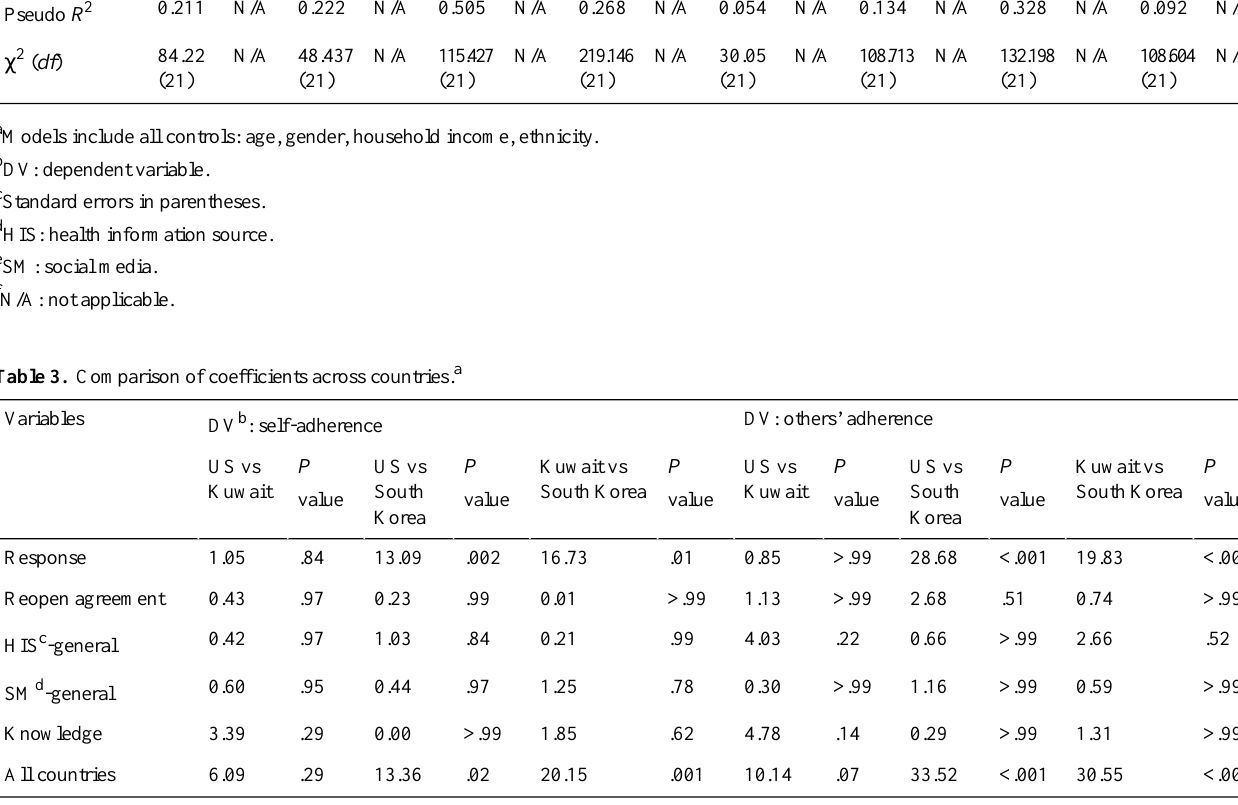
Table 3. Comparison of coefficients across countries. a